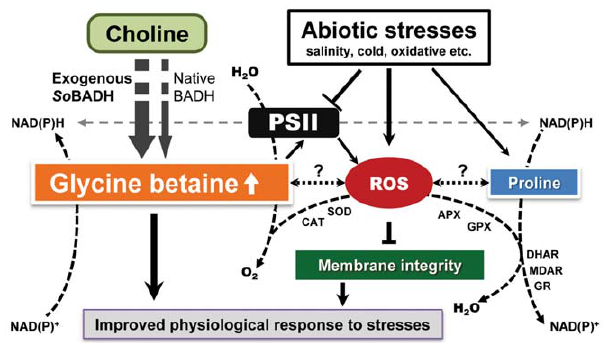
Figure 8. Crosstalks of GB biosynthesis, ROS-scavenging system and proline accumulation under stressful conditions. The overexpression of SoBADH directly causes a higher accumulation of GB, in addition to the native GB production, and alters redox homeostasis, leading to more NAD(P)H production, which facilitates proline accumulation and ROS scavenging. GB improves PSII and prohibits ROS generation. Under stress conditions, GB promotes ROS scavenging by the systemic upregulation of ROS-scavenging gene expression, which eventually protects cellular functions and membrane integrity, hence leading to an improved physiological response to the stresses. APX, ascorbate peroxidase; BADH, betaine aldehyde dehydro- genase; CAT, catalase; DHAR, dehydroascorbate reductase; GPX, glutathione peroxidase; GR, glutathione reductase; MDHAR, mono- dehydroascorbate reductase; POD, peroxidase; PSII, photosystem II; ROS, reactive oxygen species; SOD, superoxide dismutase.